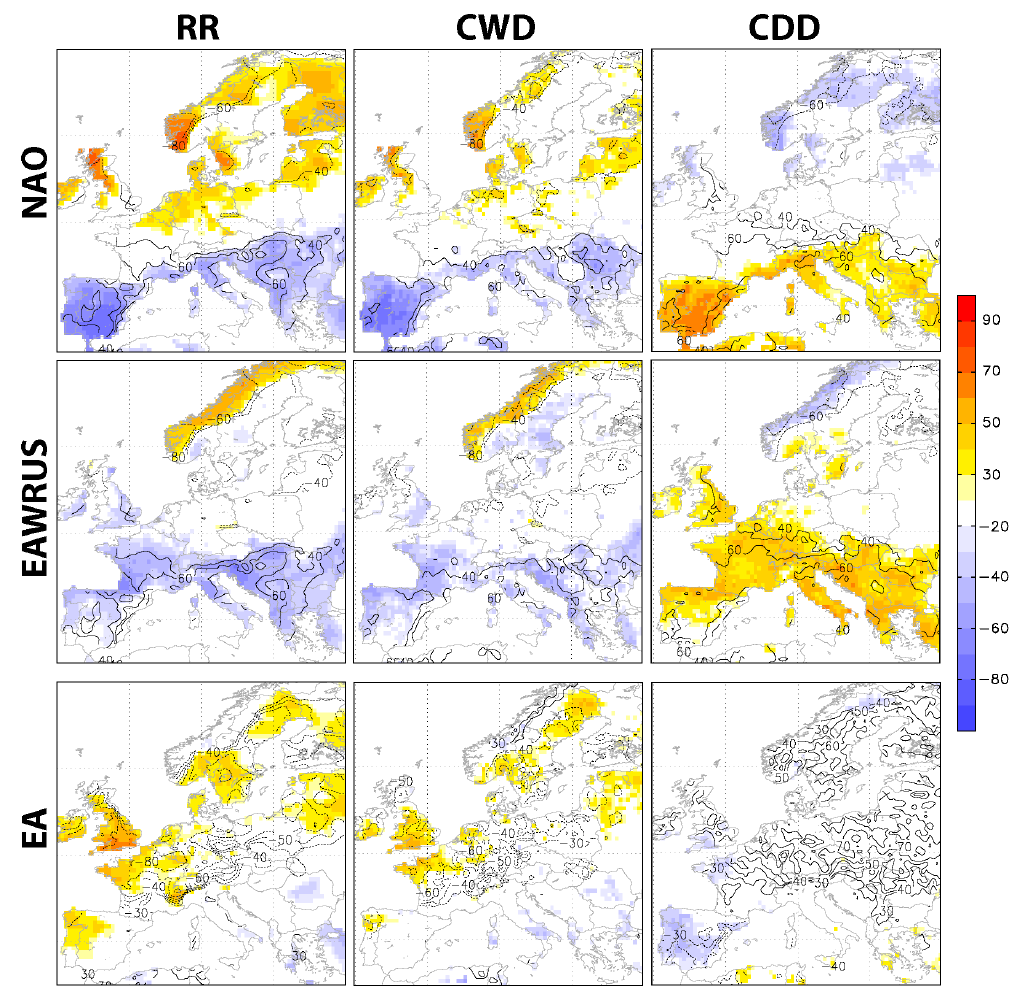
Fig. 3. Shaded regions represent the correlation coefficients ( × 100) between the teleconnection indices (NAO, EAWRUS, EA by rows) and the mean or extreme precipitation fields (by columns) in winter. Contour lines represent the EOF associated with the PC better correlated with the teleconnection index according to Table